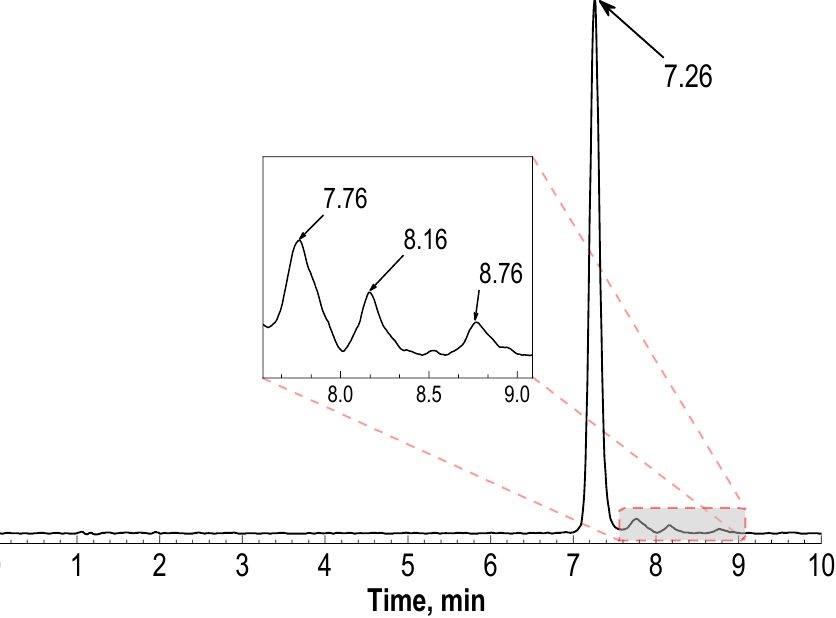
Figure 1. Typical radio-HPLC chromatogram of [ 177 Lu]Lu-PSMA-617 preparation obtained via HPLC method 3 (see Section 4): sample volume—1 mL, 177 Lu activity in the sample—150 MBq, 10 µ g of PSMA-617, pH 4.5, synthesis at 95 ◦ C for 30 min (for corresponding radio-TLC chromatograms, see Supplementary Materials Figure S1).